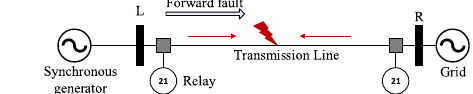
Fig. 5 Fault in TL with two power